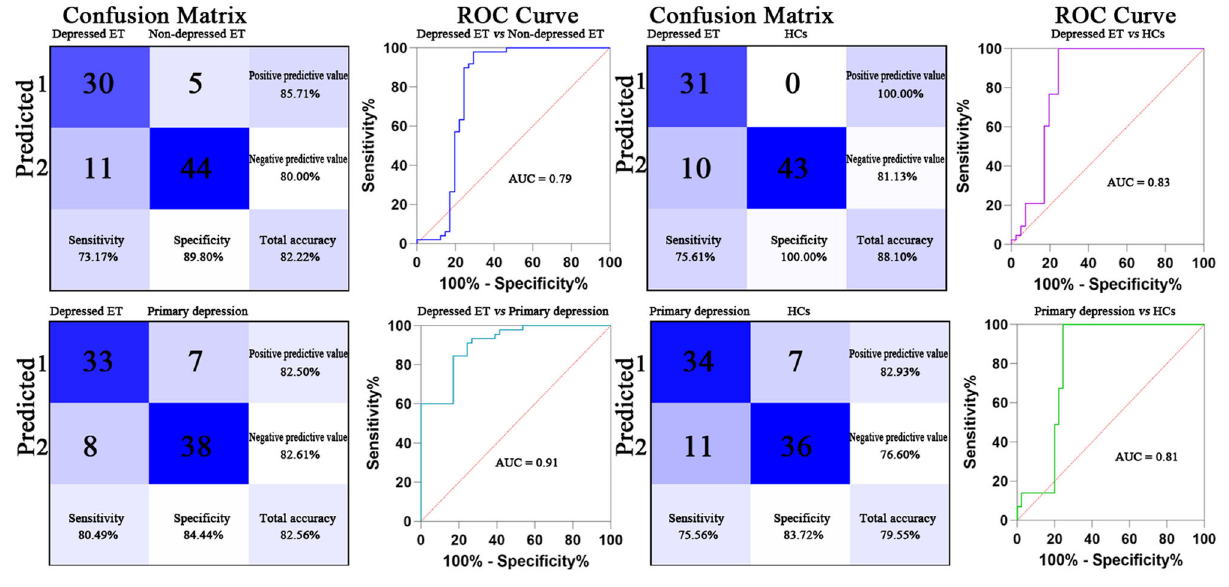
and permutation test with statistically significant balanced accuracy, sensitivity, and specificity at P <